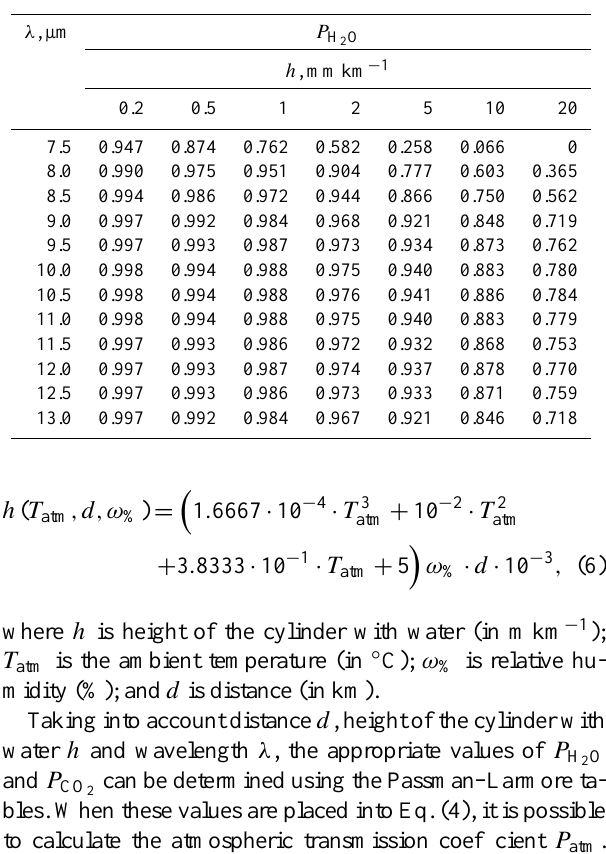
Figure 6. Characteristics of coefficient h , mkm − 1 for d = 1km, according to the Eq. (6). Table 1. A part of the Passman–Larmore table for vapour ab- sorbance P H (Gaussorgues, 1994; Passman and Larmore, 1956). 2 O